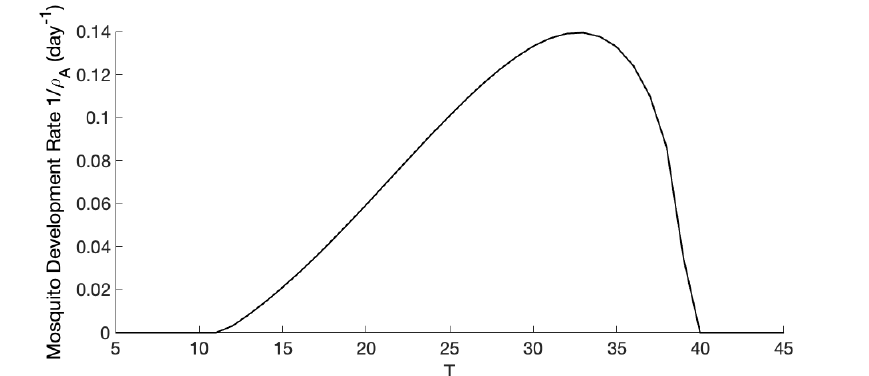
Figure A2. Adult mosquito fecundity F [8,33] and the adult mosquito development rate 1/ ρ A [24,32] as they vary with the temperature range of 0 ◦ C to 50 ◦ C .